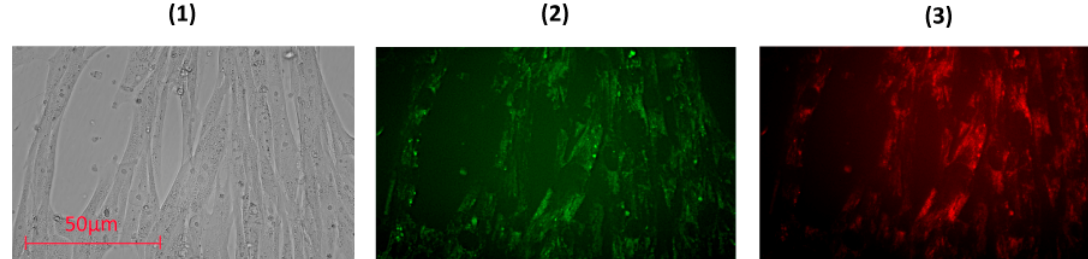
Figure 3. The 3-(4,5-dimethylthiazol-2-yl)-2,5-diphenyltetrazolium bromide (MTT) test: cell viability versus concentrations of FF1 in ( a ) 24 h and ( c ) 72 h; FF2 in ( b ) 24 h and ( d ) 72 h of incubation. In blank experiments, cells were incubated without the fullerenes.